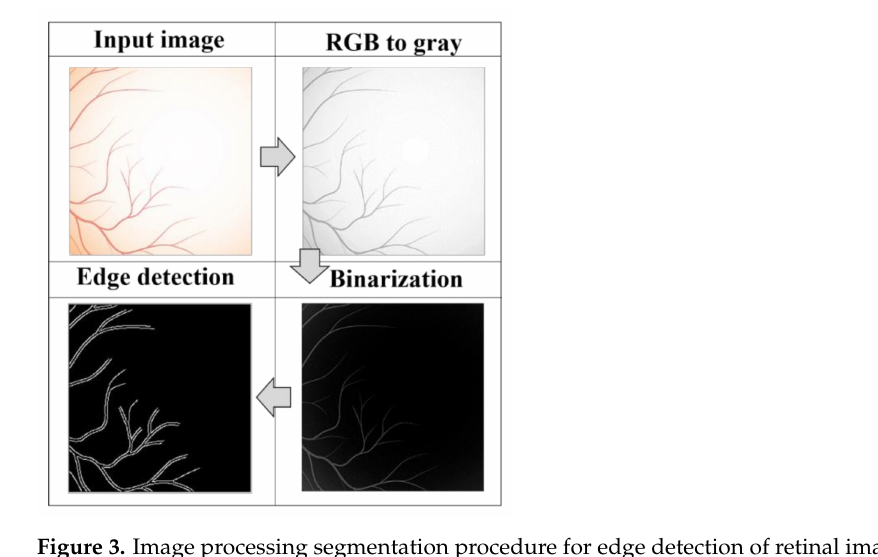
Figure 3. Image processing segmentation procedure for edge detection of retinal images. First, the RGB is converted to grayscale and binarized and then the Canny filter is